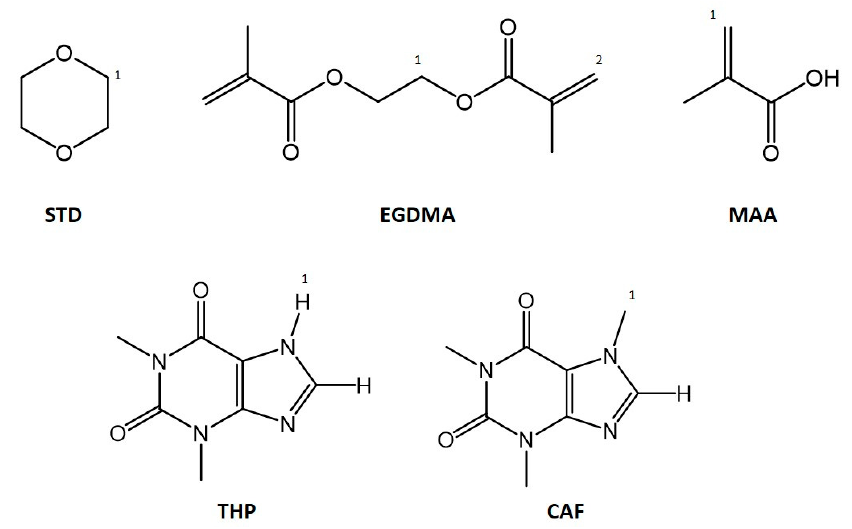
Figure 1. Structures of 1,4-dioxane ( STD ), ethylene glycol dimethacrylate ( EGDMA ), methacrylic acid ( MAA ), theophylline ( THP ) and caffeine ( CAF ). Labelled atoms correspond to nuclei used for NMR analysis.